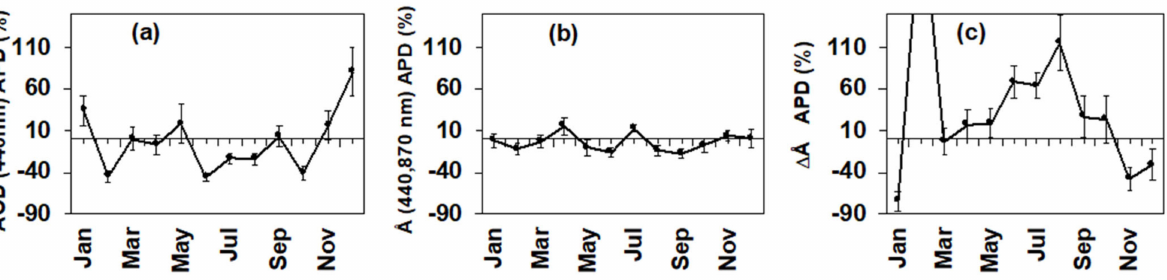
Figure 3. Time series of monthly average percent departure (APD%) in the year 2020 with respect to the reference years (2017, 2018, and 2019) for ( a ) Aerosol Optical Depth AOD at 440 nm, ( b ) Ångström Exponent Å at the wavelength pair 440–870 nm, and ( c ) Ångström Exponent difference ∆ Å. Error bars represent the corresponding uncertainty estimated by the propagation of error on the